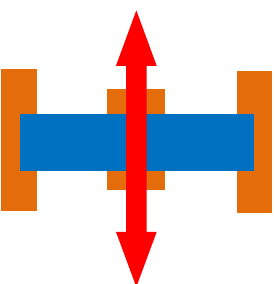
Figure 2. Simplified model of double cantilever mode.